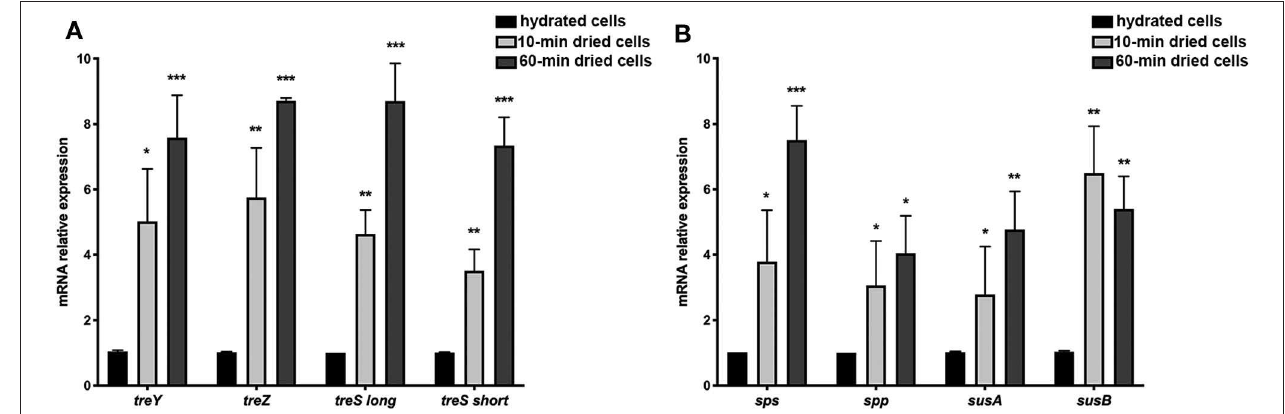
FIGURE 1 | Expression of trehalose and sucrose biosynthetic genes in 10- and 60-min dried Chroococcidiopsis cells. Gene expression of TreY/TreZ and TreS trehalose biosynthetic pathway genes (A) ; gene expression of SPS/SPP and SUS sucrose biosynthetic pathways (B) . Values in hydrated cells were considered as control values and set to 1. Data represent mean ± SD ( n ≥ 3), *** p < 0.001, ** p < 0.01, and * p < 0.05.